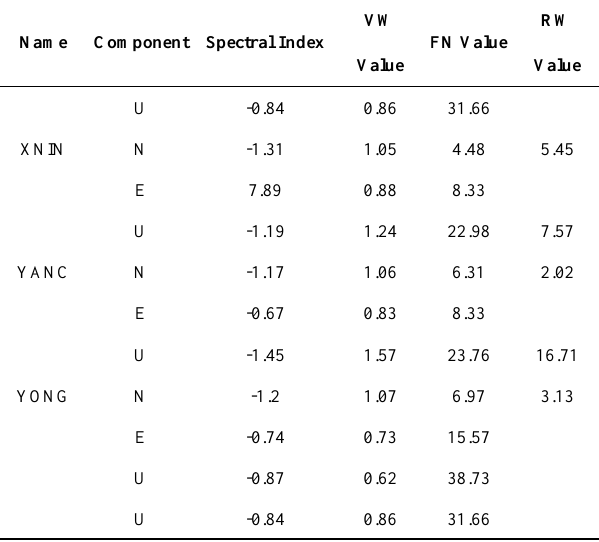
Table 1. Results of spectral index and estimated parameters of noise property based on FN+VW+RW model (unit: mm) VW corresponds to the variable white noise, FN corresponds to FLICKER noise; RW corresponds to stochastical noise.